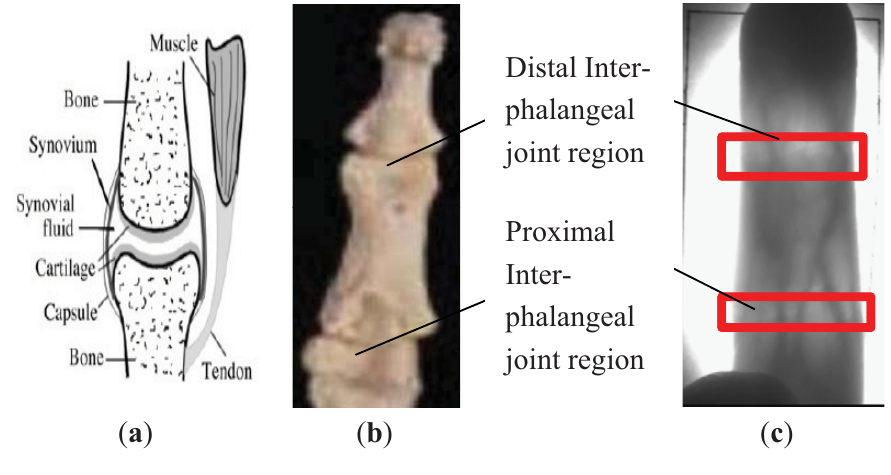
Figure 4. Phalangeal joint. ( a ) The structure of a phalangeal joint; ( b ) Phalanx